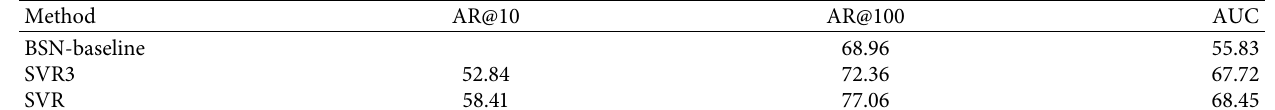
Table 2: Experimental results of 2D convolution timing-channel joint modeling.